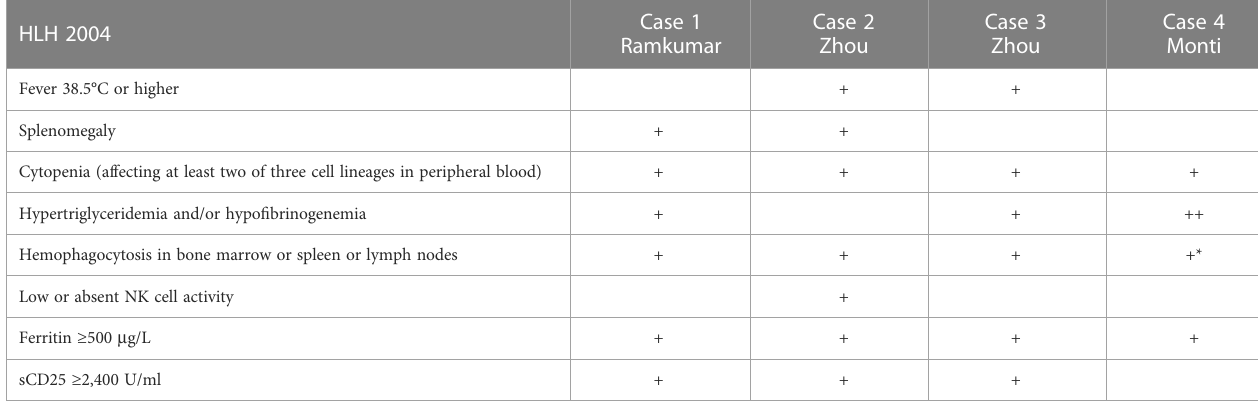
TABLE 1 Cases and hemophagocytic lymphohistiocytosis (HLH) 2004 diagnostic criteria. HLH